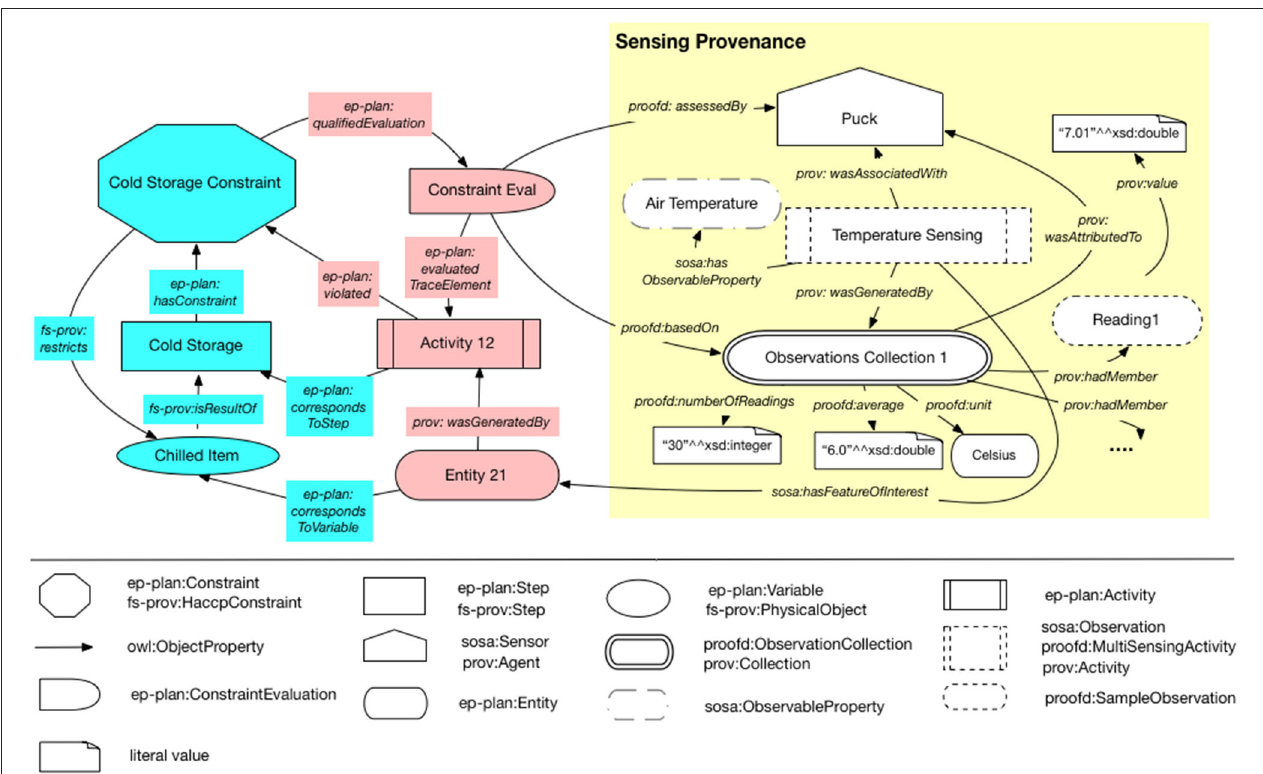
FIGURE 9 | An example record illustrating the use of the ep-plan:ConstraintEvaluation concept to link elements describing additional sensor information (e.g., number of sensor readings, units of observation, etc.) and documenting the context in which a constraint was